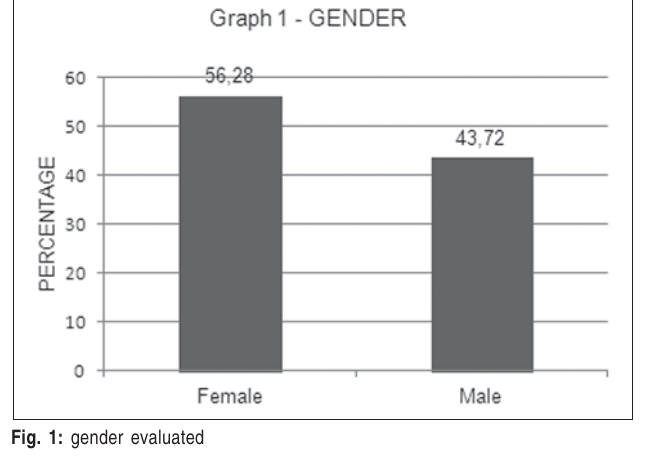
Fig. 4: tooth group